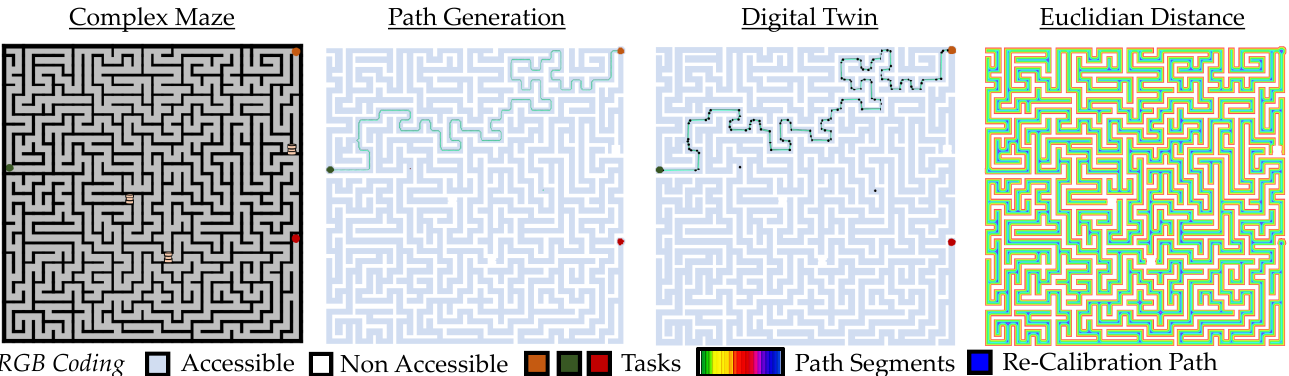
Figure 21. Path generation in a complex maze: RGB map, path generation, the graph for digital twin, Euclidean distance transformation.